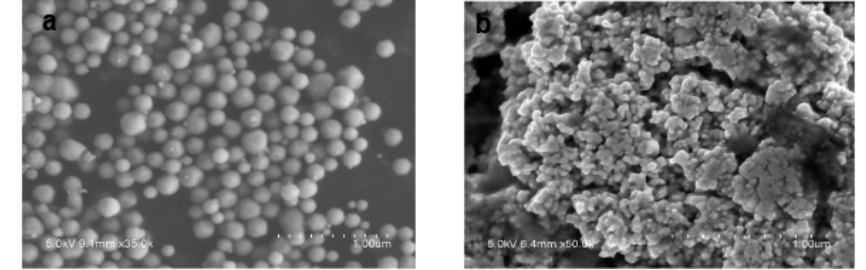
Figure 3. Characterization of the prepared Ag nanoparticles by SEM images: ( a ) prepared at low concentration of C 7 H 6 O, ( b ) prepared by CH 2 O.